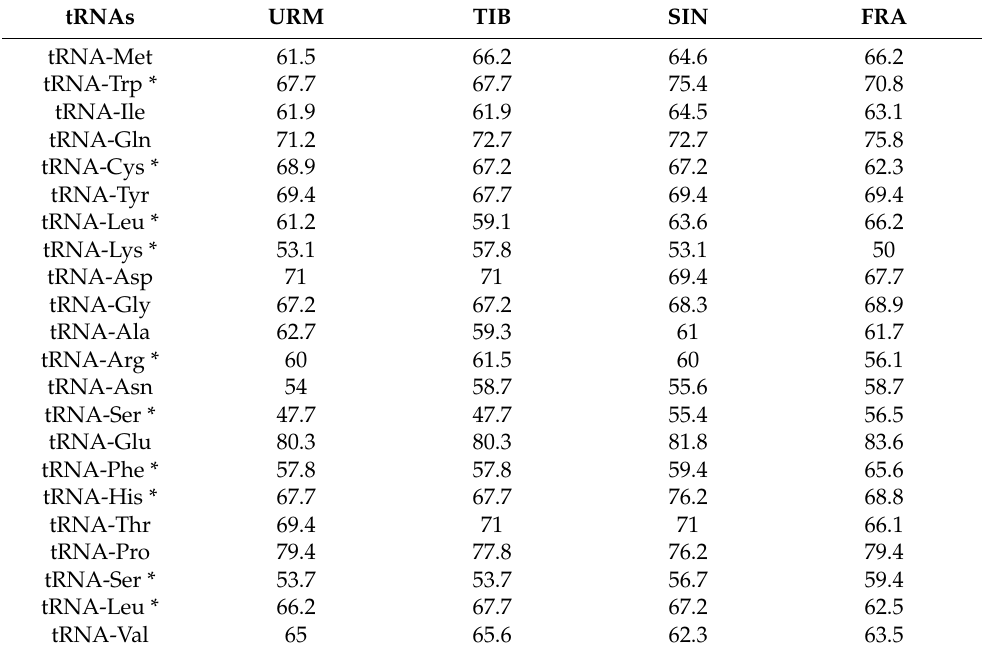
Table 1. AT content (%) of tRNAs genes in Artemia mitogenomes. “*” shows the tRNA with >5% difference in AT content (URM: A. urmiana , TIB: A. tibetiana , SIN: A. sinica , FRA: A. franciscana ). tRNAs URM